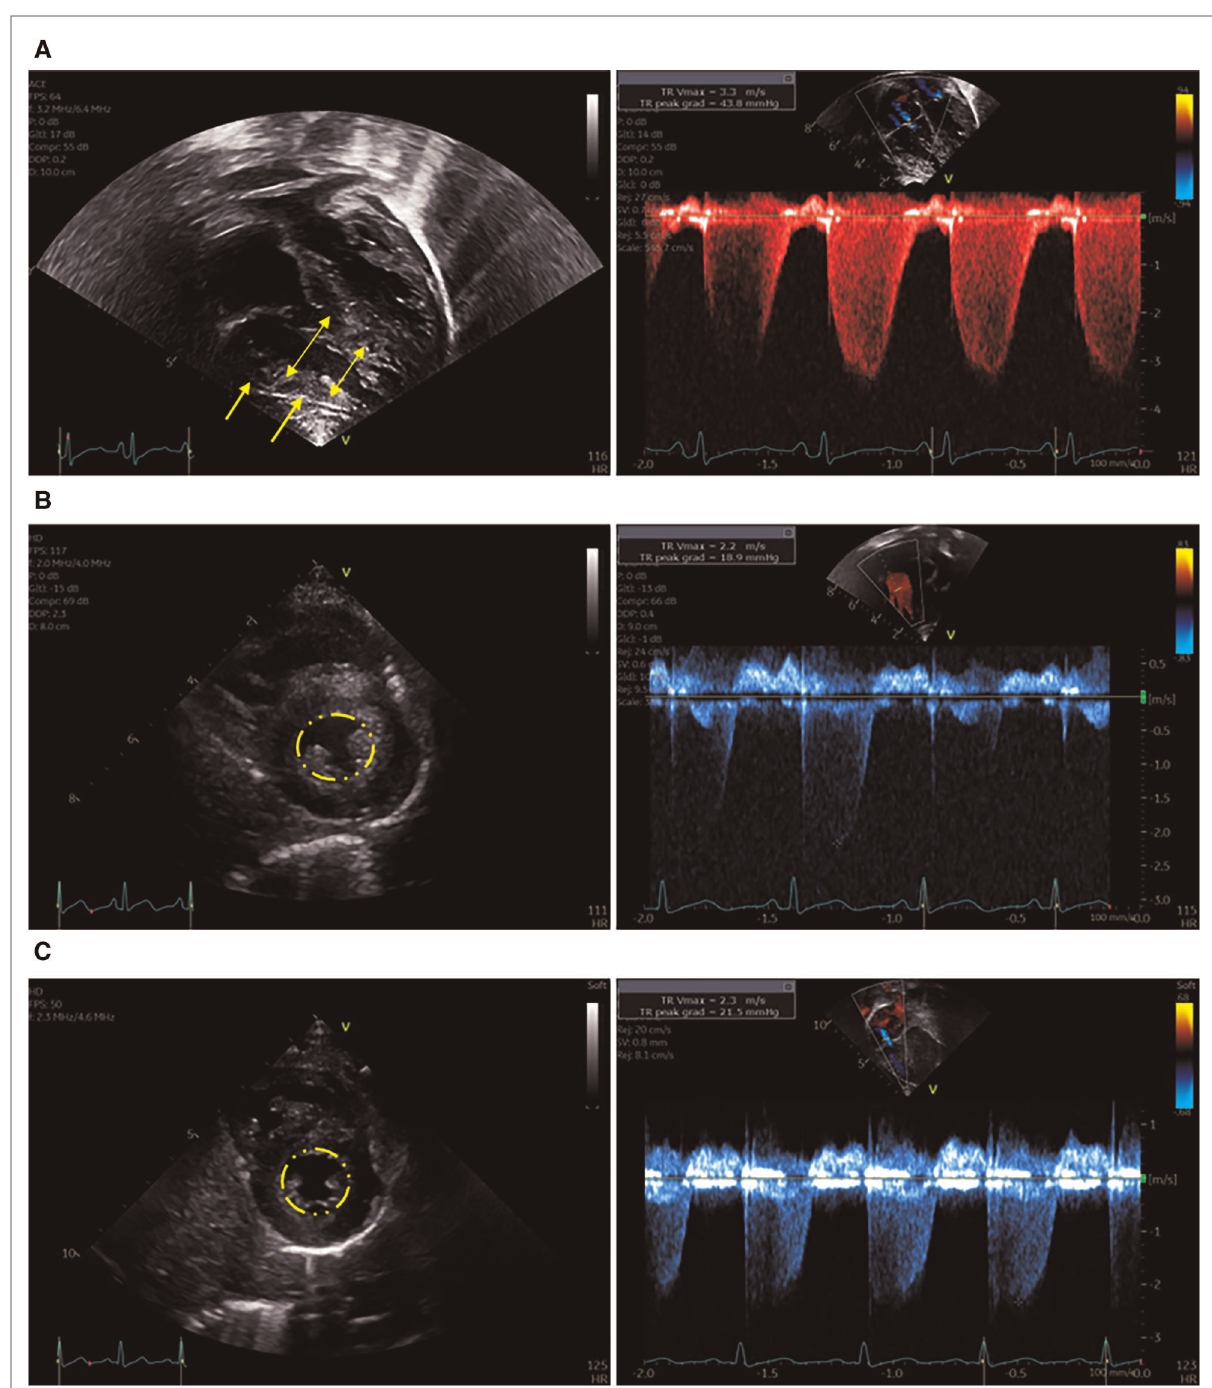
FIGURE 1 Representative images from echocardiograms obtained during the patient ’ s course. ( A ) Immediately after cardiac arrest while on ECMO. Left panel: Apical 4-chamber view demonstrates right ventricular dilation (double headed arrows) and hypertrophy (single headed arrows). Right panel: Increased peak velocity of the tricuspid valve regurgitation jet indicates elevated right ventricular pressure. ( B ) Four weeks after cardiac arrest – on sildena fi l. Left Panel: Parasternal short axis image demonstrates normal end-systolic septal position (indicated by circle), normal right ventricular size, and mild right ventricular hypertrophy. Right Panel: Normal peak velocity of the tricuspid valve regurgitation jet indicates normal right ventricular pressure. ( C ) Nine months after cardiac arrest – off sildena fi l. Left Panel: Parasternal short axis image demonstrates normal end- systolic septal position (indicated by circle), normal right ventricular size, and no right ventricular hypertrophy. Right Panel: Normal peak velocity of the tricuspid valve regurgitation jet indicates normal right ventricular